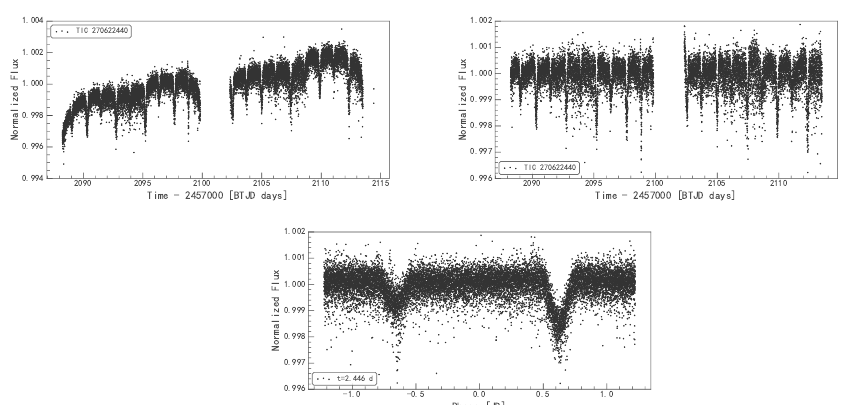
Figure 9. TESS light curve of HD 224112 (Sector 29). From top to bottom, we show light curves before detrending, after detrending, and phase-folded to the period of 2.446